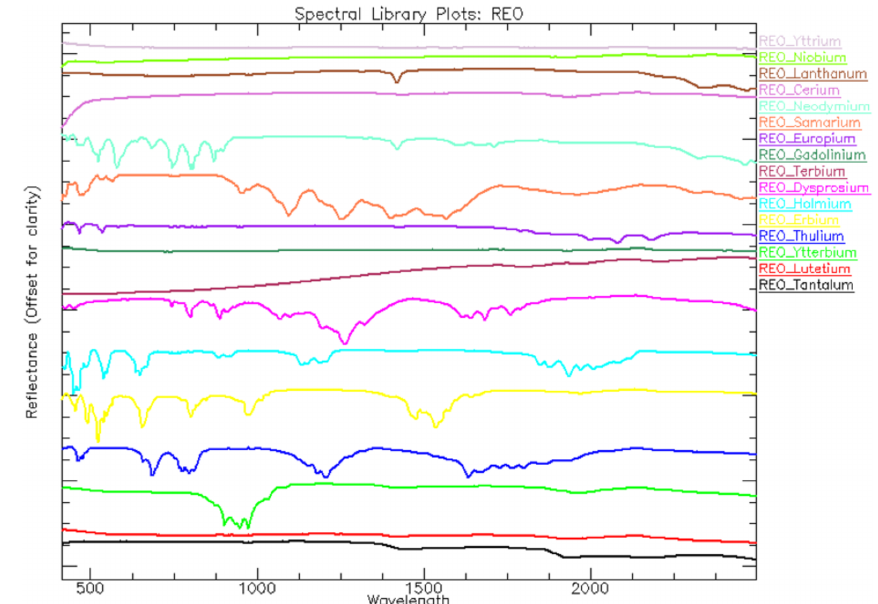
Figure 9. Spectral library plot of the rare-earth oxide powders.